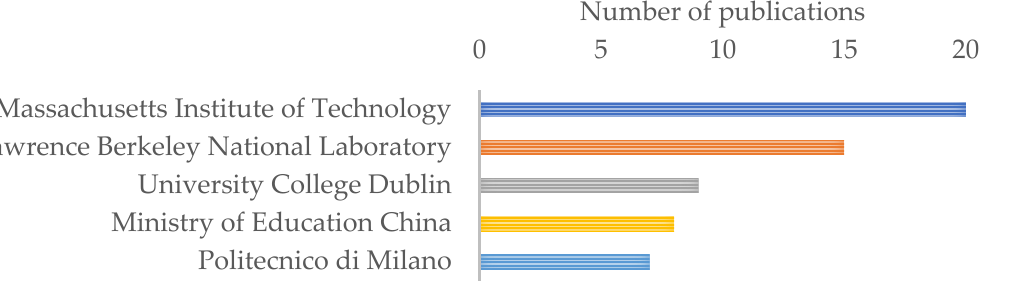
Figure 9. Top five research sponsors with publications in physics-based urban building energy modeling.